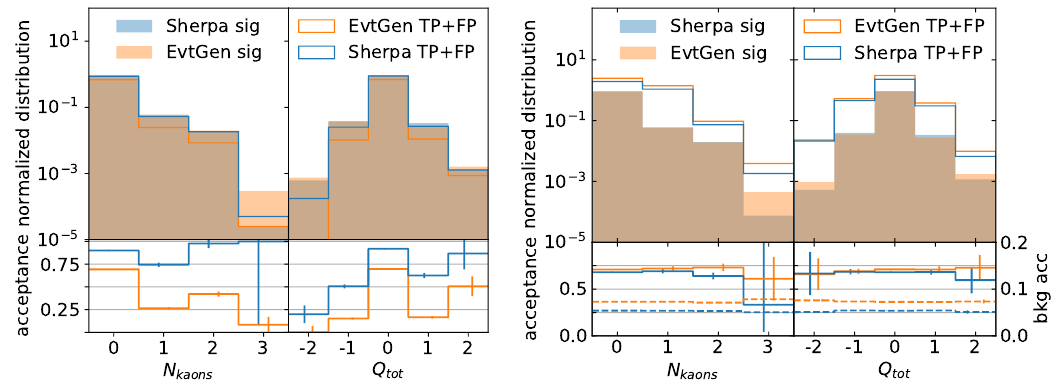
Figure 15 . As in figure 8, but using S HERPA instead of E VT G EN data for training the BNNs.